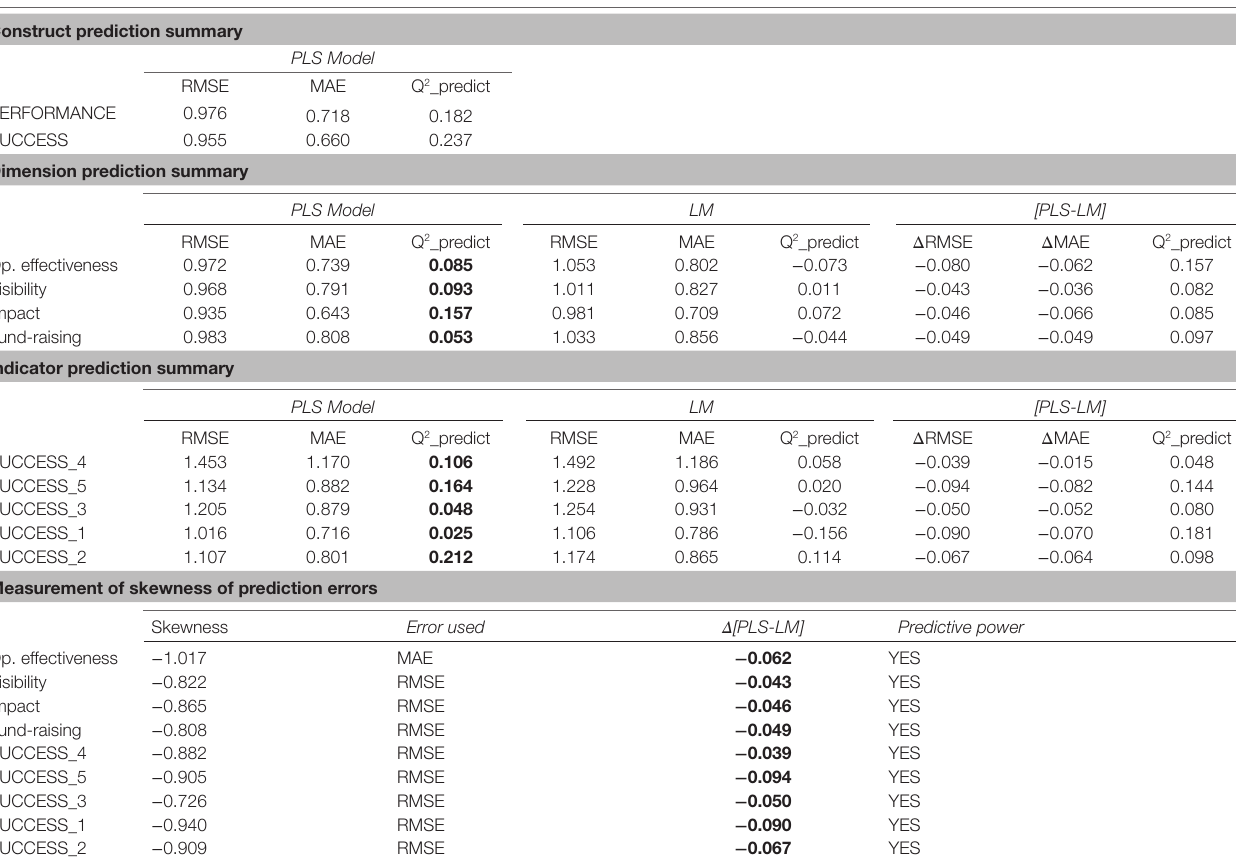
TABLE 11 | Analysis of the model’s predictive